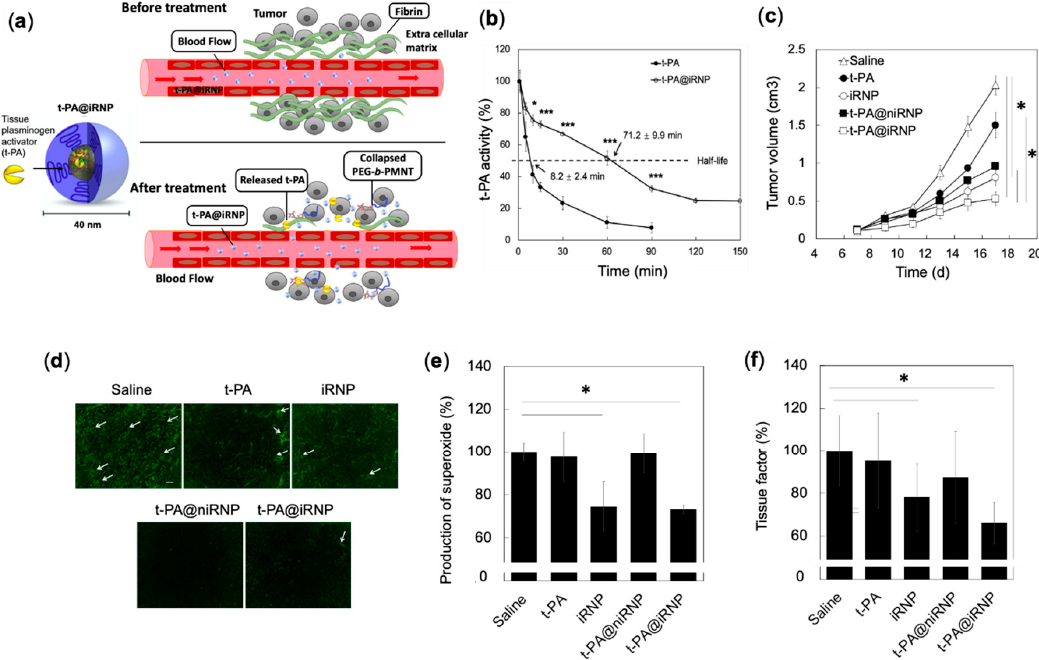
Figure 7. Anti-tumor effect of fibrinolytic tissue plasminogen activator installed in radical containing nanoparticles (t-PA@iRNP). ( a ) Schematic illustration of the delivery and therapeutic effect of t-PA@iRNP in tumors characterized by dense fibrin extracellular matrix [112]. ( b ) Ex vivo thrombolytic activity of t-PA enzyme, after intravenous administration in mice with equimolar dose of naked t-PA and t-PA@iRNP, measured using t-PA’s ability to hydrolyze a tri-peptide chromogenic substrates of H-D-isoleucyl-l-prolyl-L-arginine-p-nitroanilide dihydrochloride to p-nitroaniline. Liberated p-nitroaniline was measured spectrophotometrically at 405 nm by using a UV-Vis spectrometer [113]. ( c ) Tumor growth profile in a C-26 colon murine cancer model, intravenously administered (5 times) with saline (control), t-PA (0.04 mM), and iRNP (TEMPO; 5.3 mM). ( d ) Representative images of fibrin immunofluorescence (white arrow) in the tumor tissues, scale bar 10 µ m. ( e ) Superoxide level in tumor tissue homogenate measured by ROS sensitive dye, dihydroethidium. ( f ) Tissue factor in tumor lysates measured by ELISA [112]. * p < 0.05 was considered significant. This figure is reproduced with permission